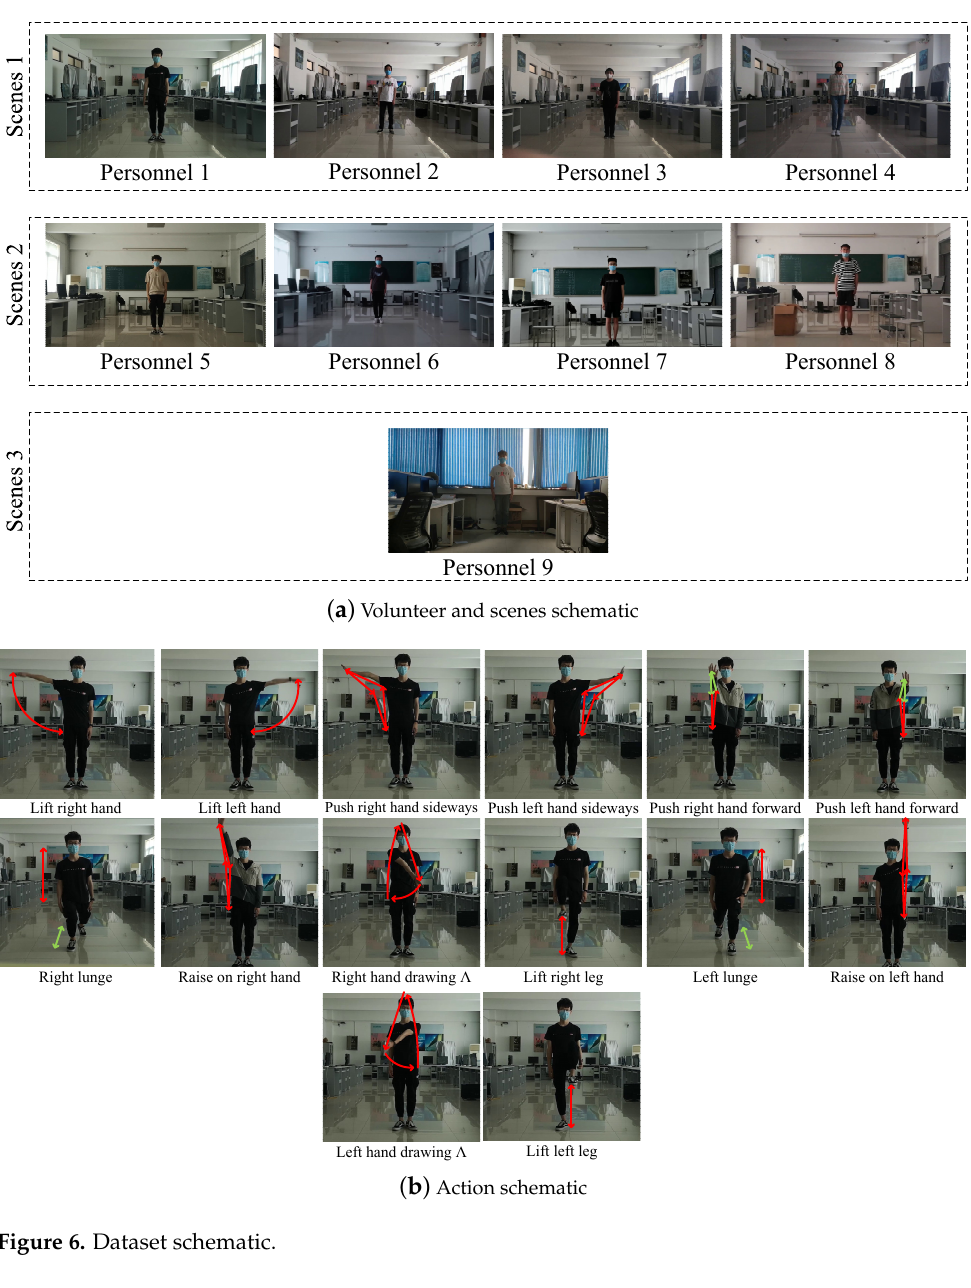
Figure 6. Dataset